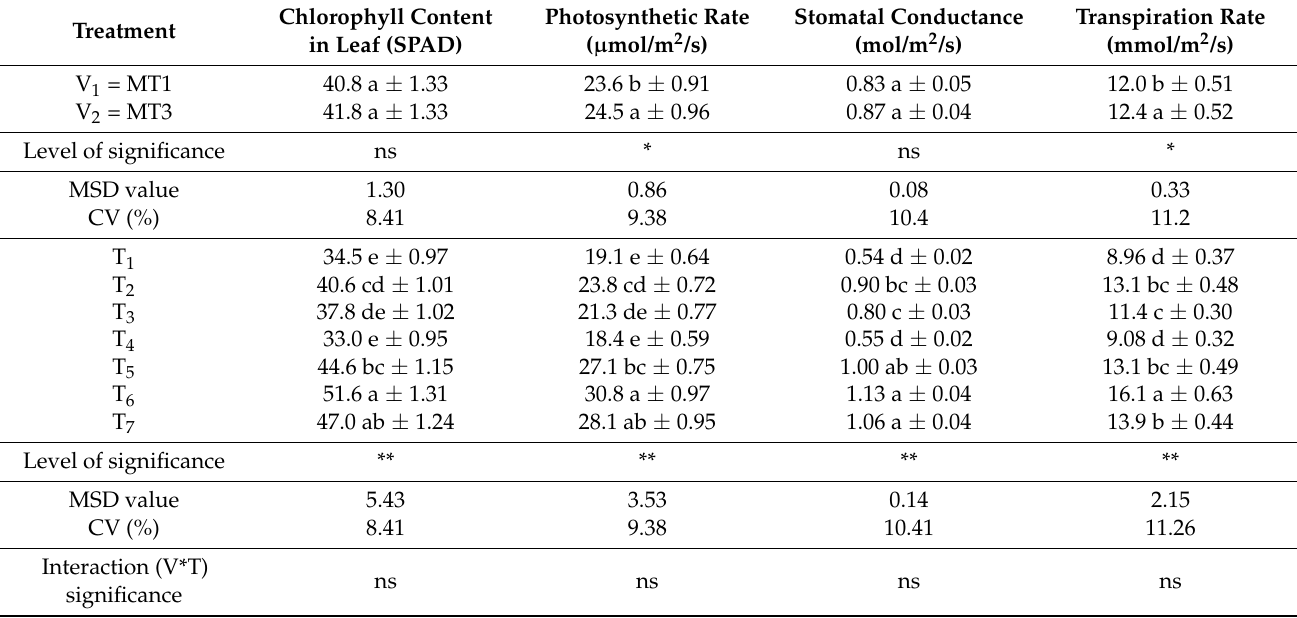
Table 3. Effect of zinc fertilizer and zinc oxide nanoparticles on physiological growth traits of two selected tomatoes